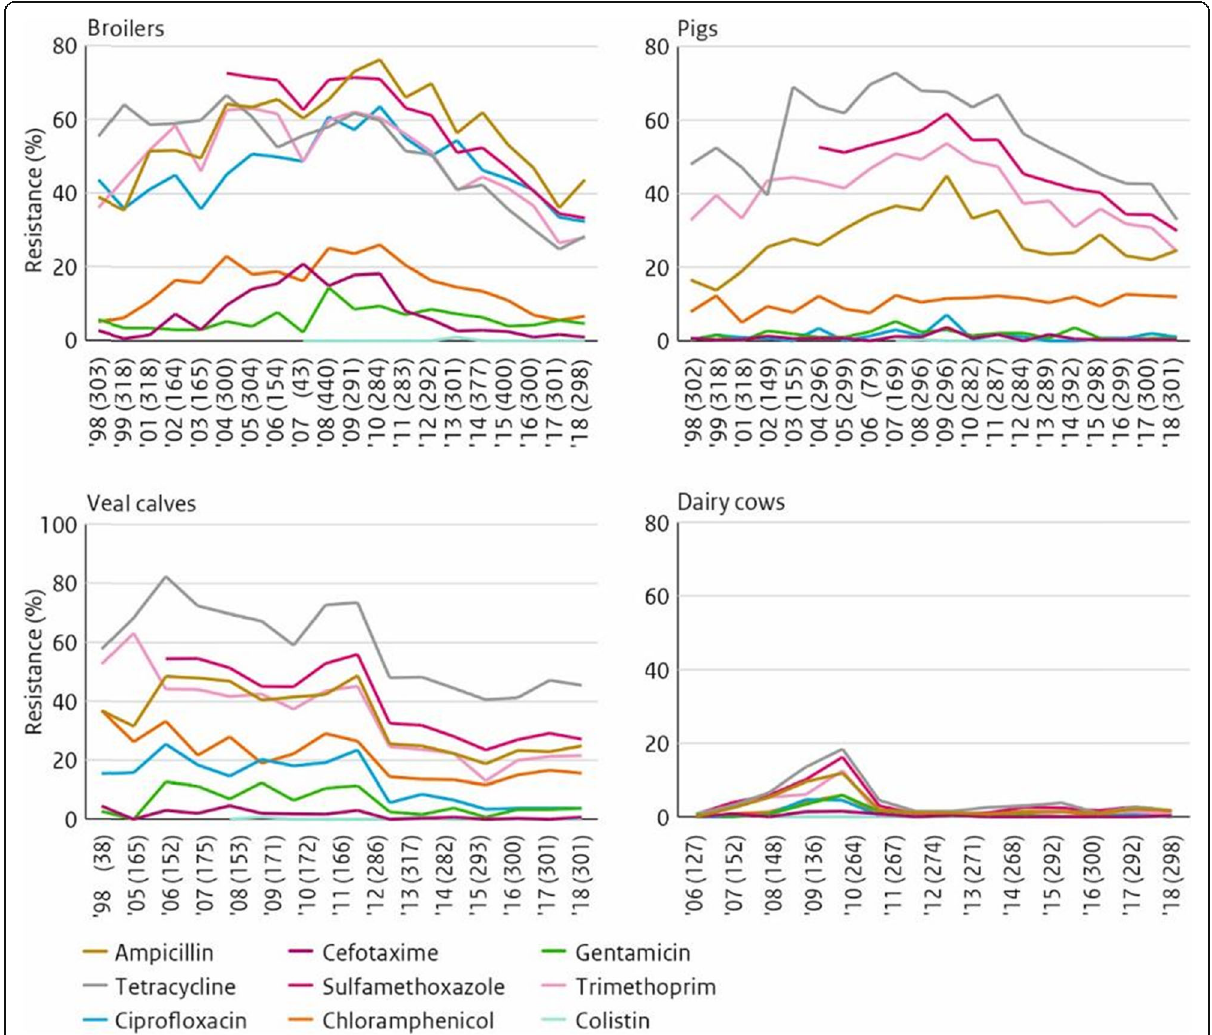
Fig. 11 Antimicrobials resistance in commensal E. coli in animals (rectal swabs in slaughterhouse). Percentage of resistance for different antimicrobials in different